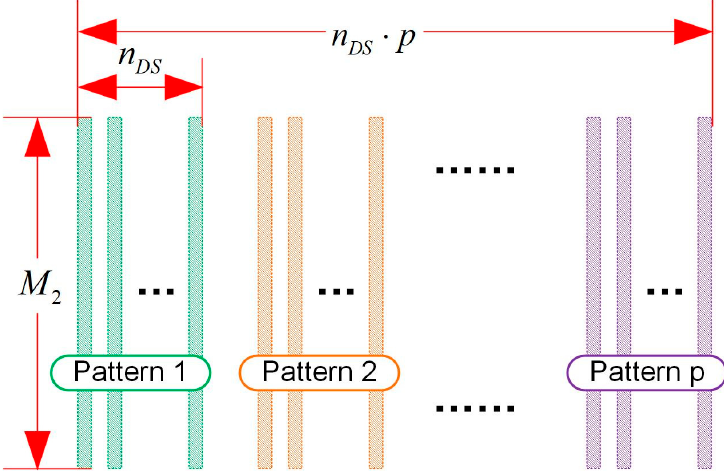
Figure 4. Redundant dictionary matrix.